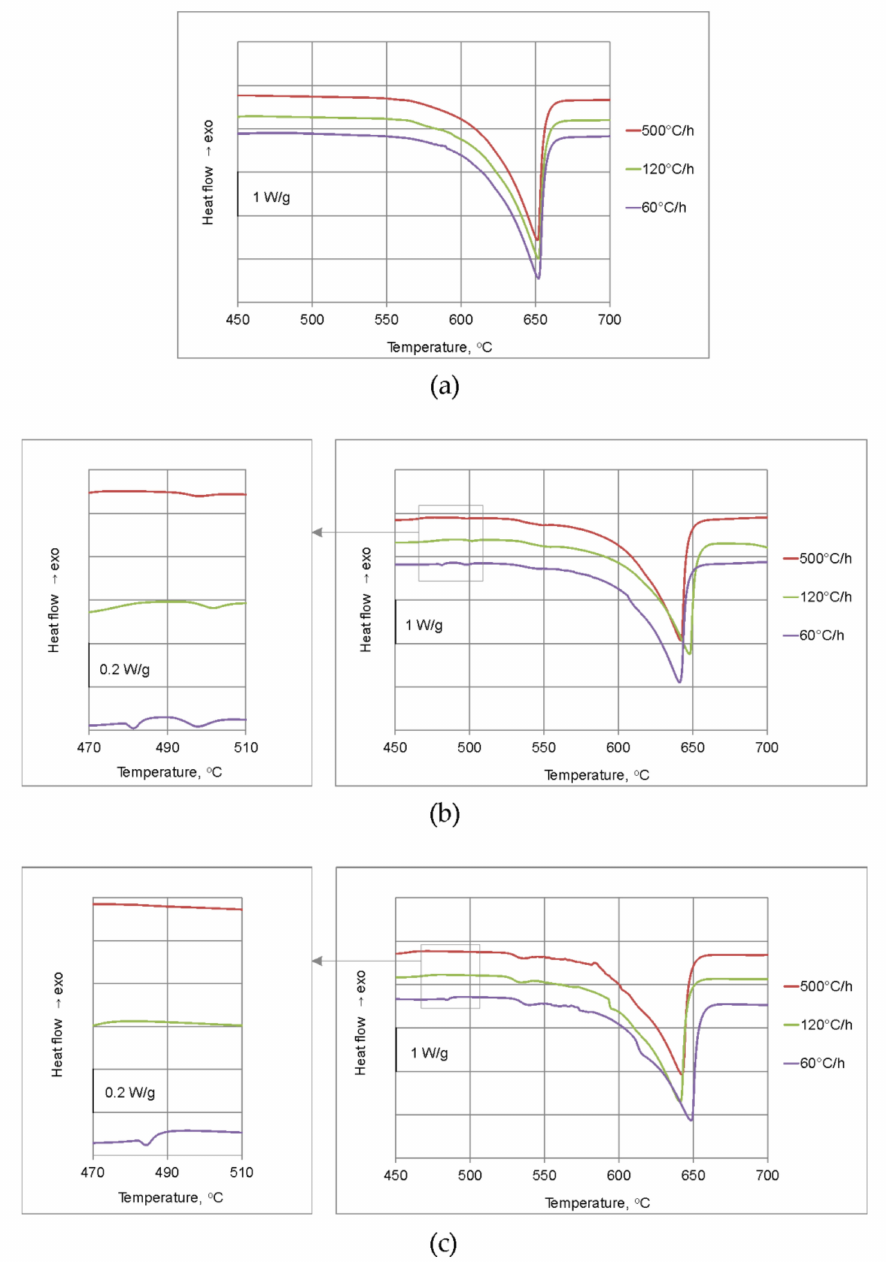
Figure 9. DSC curves of alloys subjected to various cooling rates from homogenization temperature: ( a ) 7075 alloy 1 after homogenization with soaking at 465 ◦ C for 4 h; ( b ) 7075 alloy 2 after homoge- nization with final soaking at 475 ◦ C for 8 h; ( c ) 7049 alloy 4 after homogenization with soaking at 465 ◦ C for 12